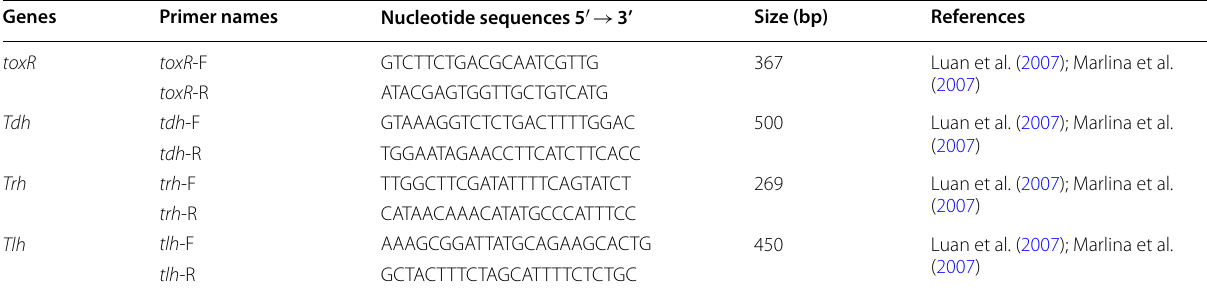
Tdh , Thermostable direct hemolysin; trh , TDH-related hemolysin; tlh , Thermolabile hemolysin; toxR , Toxin operon (Luan et al. 2007; Marlina et al. 2007)